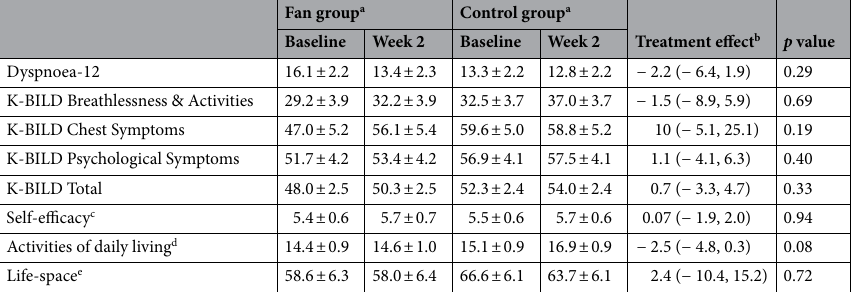
Table 2. Patient-reported outcome measures between baseline and Week 2. Measured using: c Self-efficacy for Managing Chronic Disease 6-item Scale; d Manchester Respiratory Activities of Daily Living Questionnaire; e University of Alabama at Birmingham Study of Aging Life-Space Assessment. Data are expressed as a mean ± standard error or b mean difference (95% confidence interval). P values are between group comparison for mean difference. K-BILD King’s Brief Interstitial Lung